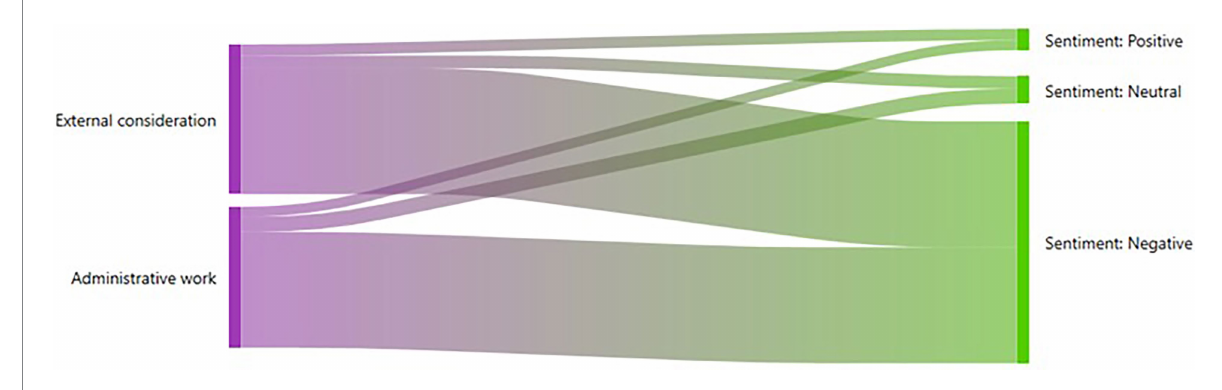
FIGURE 4 Sankey diagram of concurrence between central categories and sentiment.